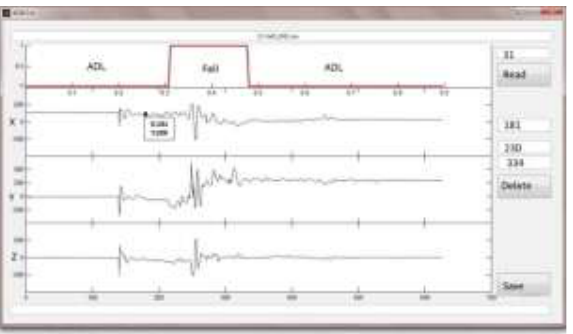
Fig. 5. GUI application for trimming the recorded acceleration signals